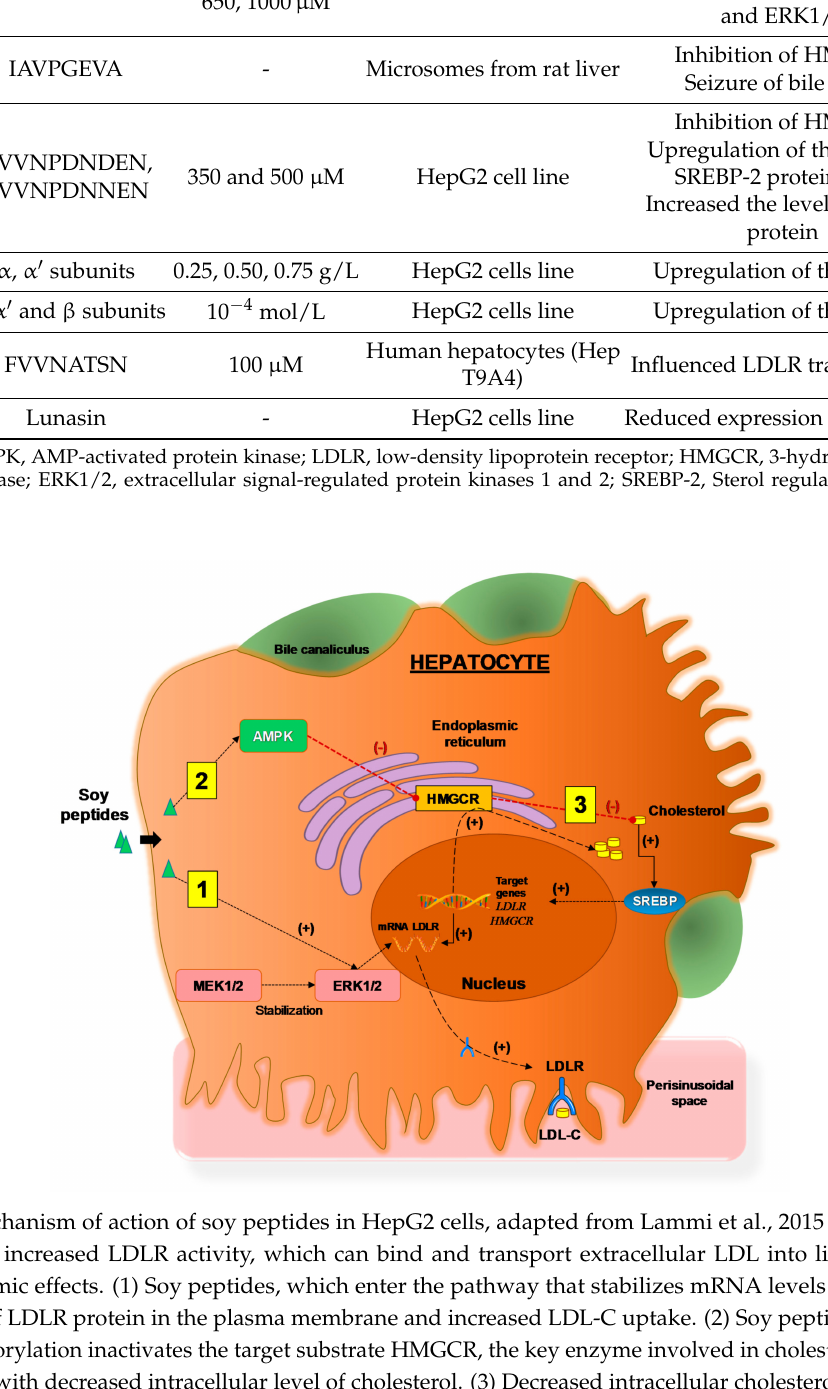
Table 2. Effect of soy proteins and peptides on lipid metabolism.